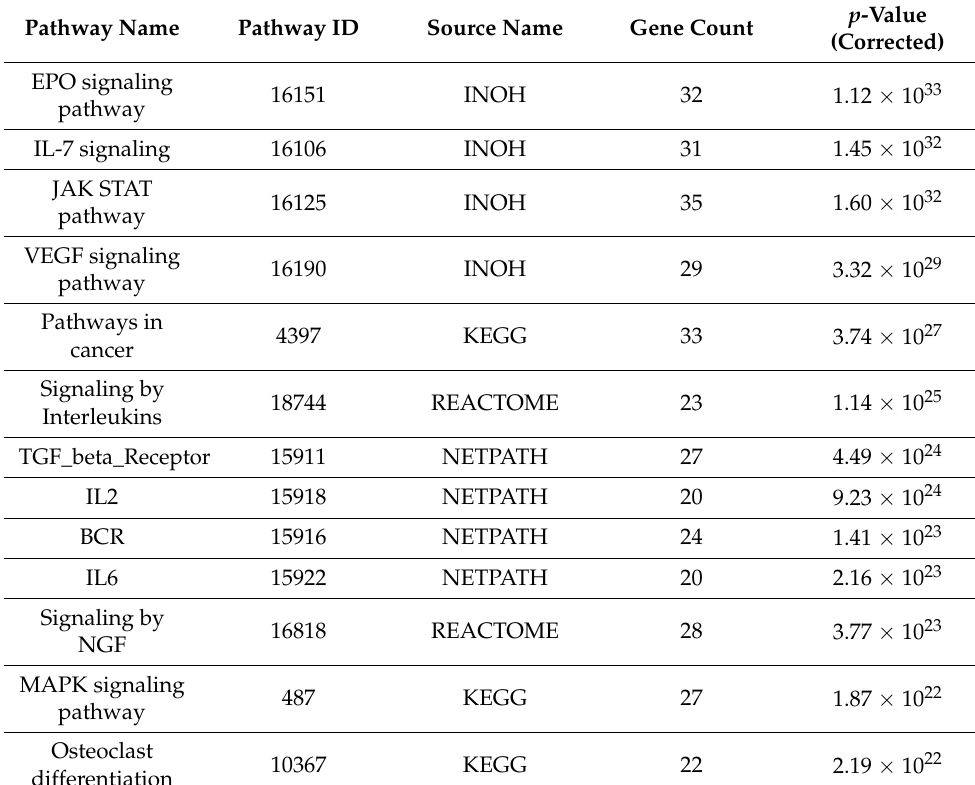
Table 6. Pathway Overrepresentation Analysis PCEP in Draining Lymph Node.